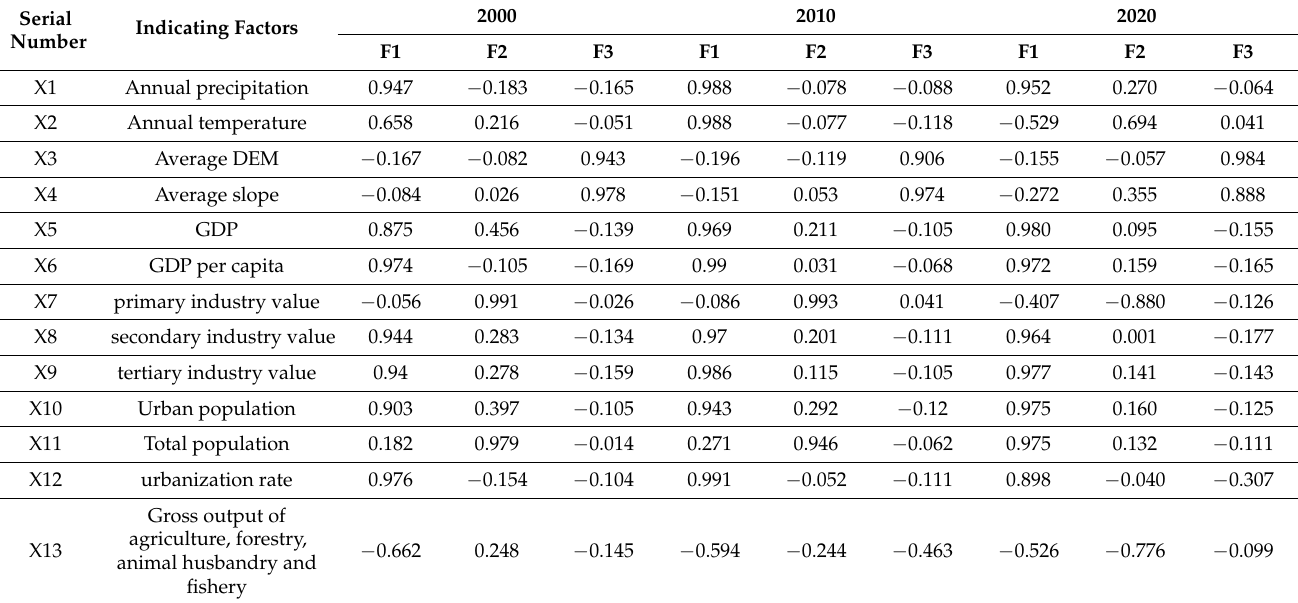
Table 5. Rotation load matrix of principal components in each year of Chaohu Lake